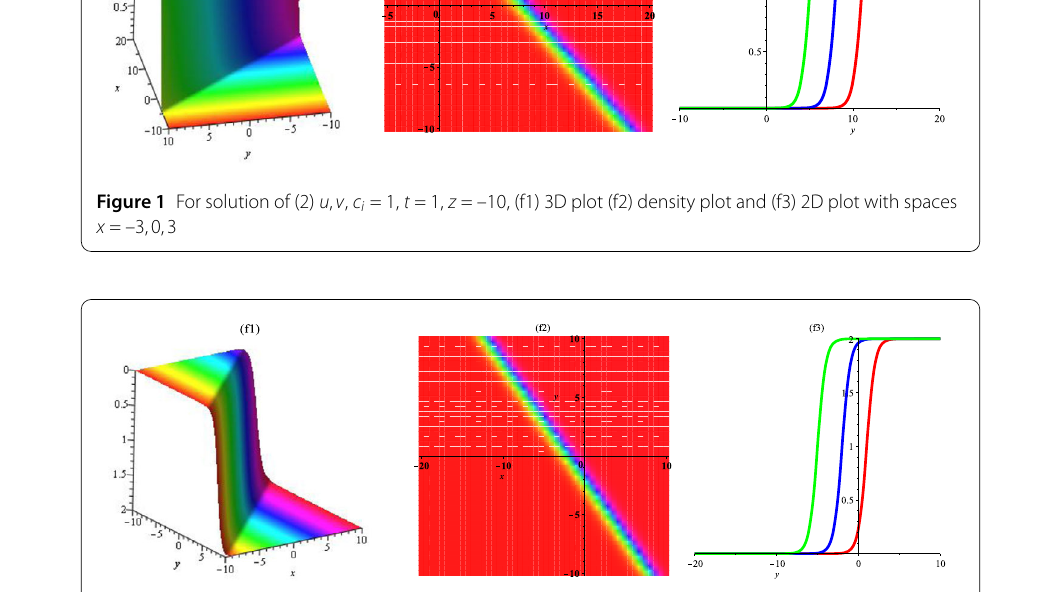
Figure 2 For solution of (2) u , v , c i = 1, t = 1, z = 0, (f1) 3D plot (f2) density plot and (f3) 2D plot with spaces x = –3,0,3